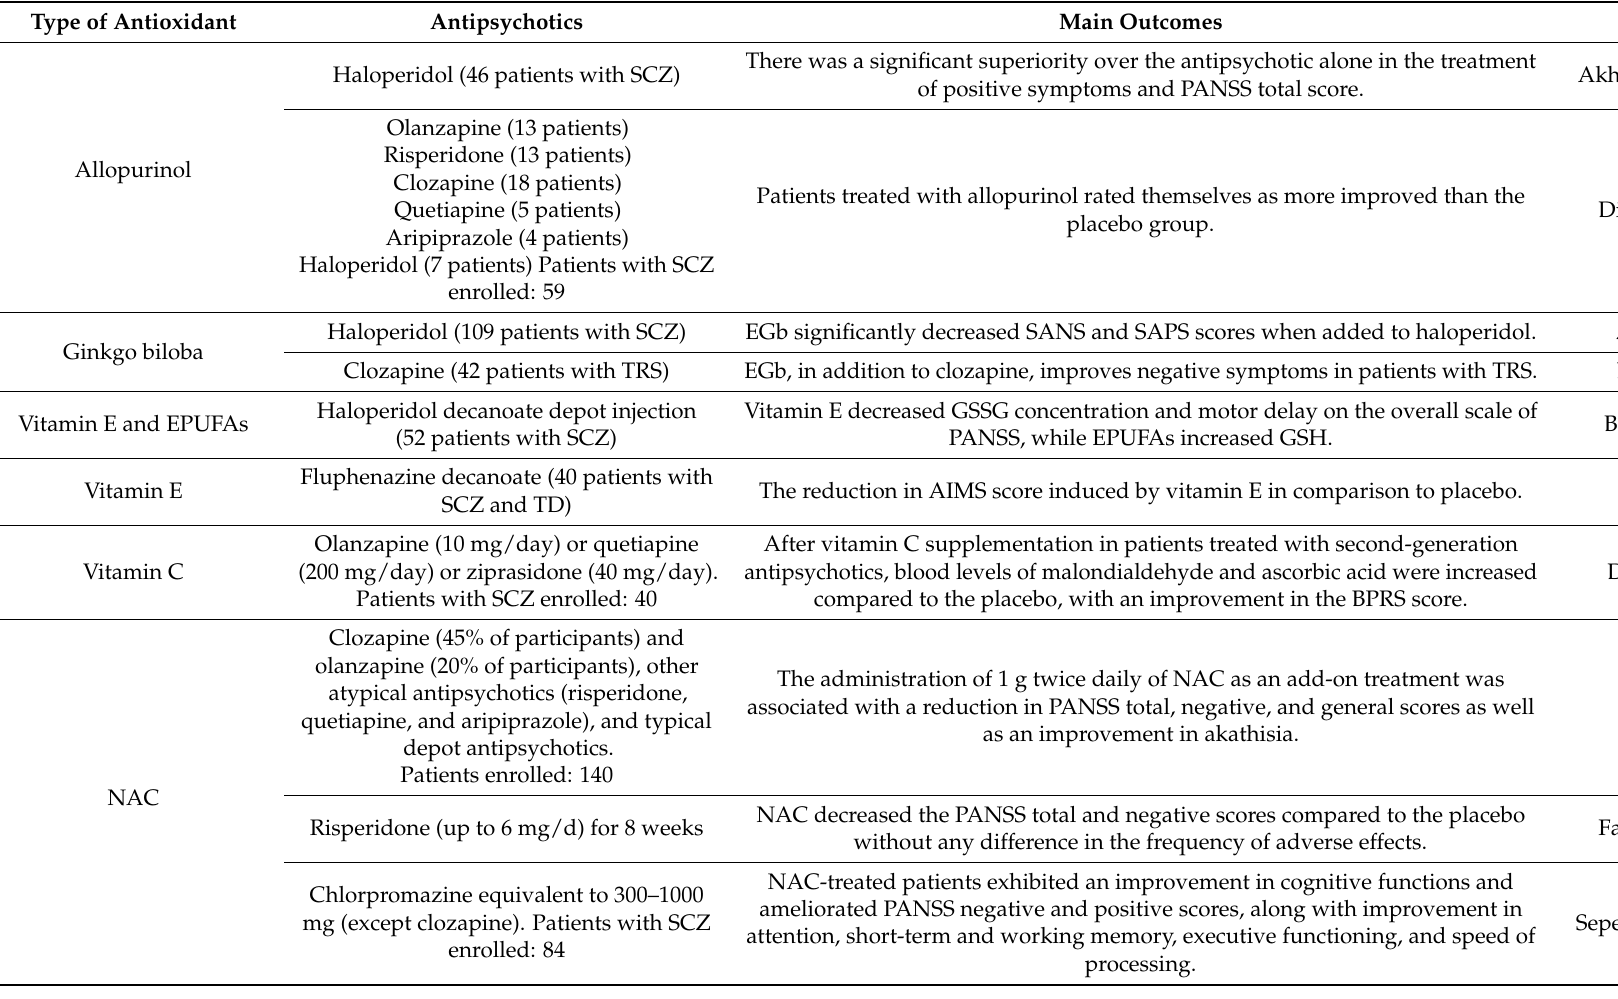
Table 2. RCTs of antioxidant agents as add-on treatment in patients with psychotic